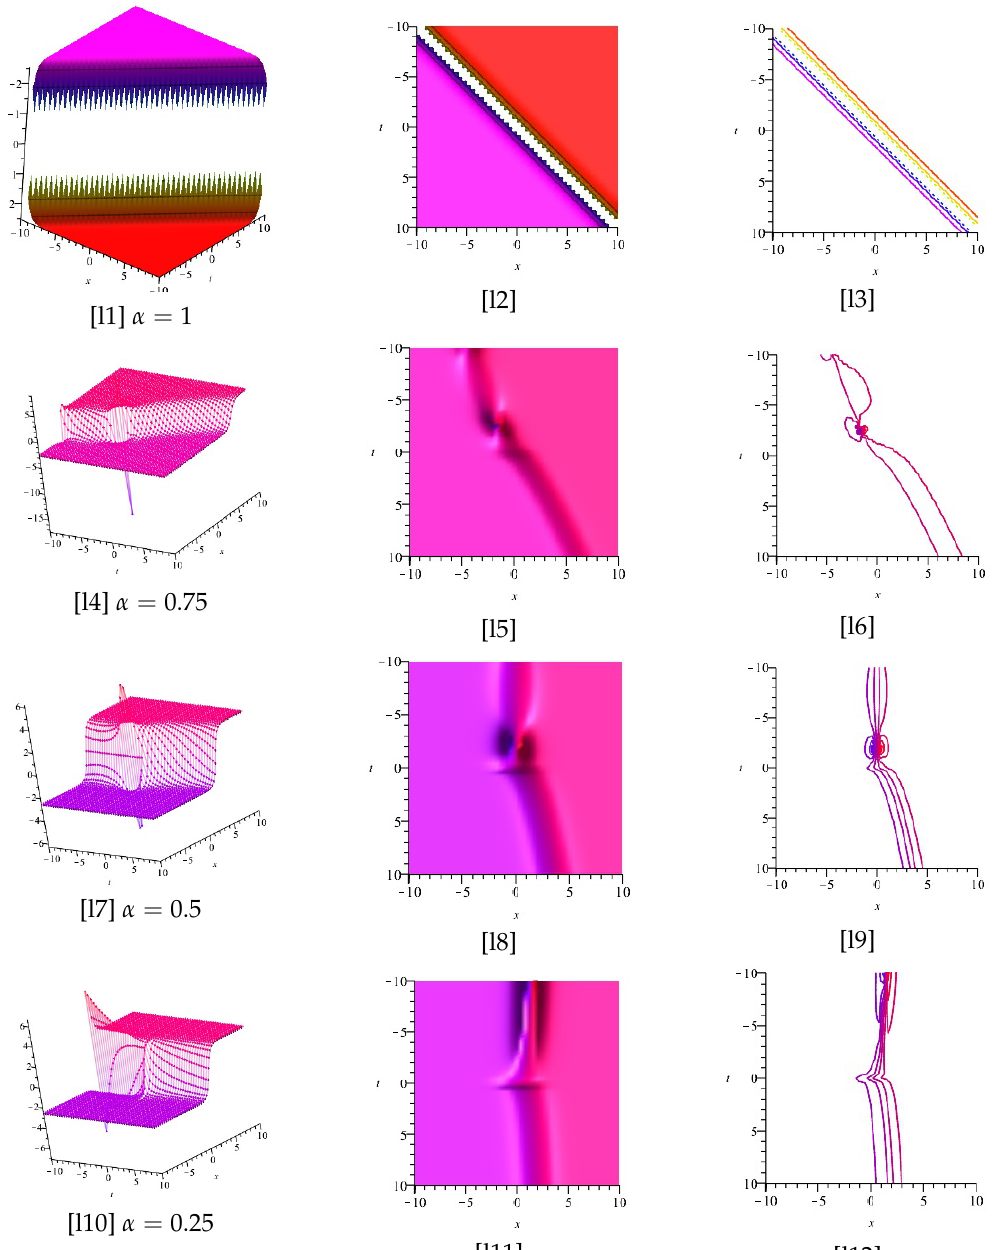
Figure 12. Now, [l1], [l4], [l7], and [l10] display the plots of the imaginary part of Equation (34), for λη < 0, and [l2], [l5], [l8], and [l11], as well as [l3], [l6], [l9], and [l12], display the z -axis orientation and the contour plot,